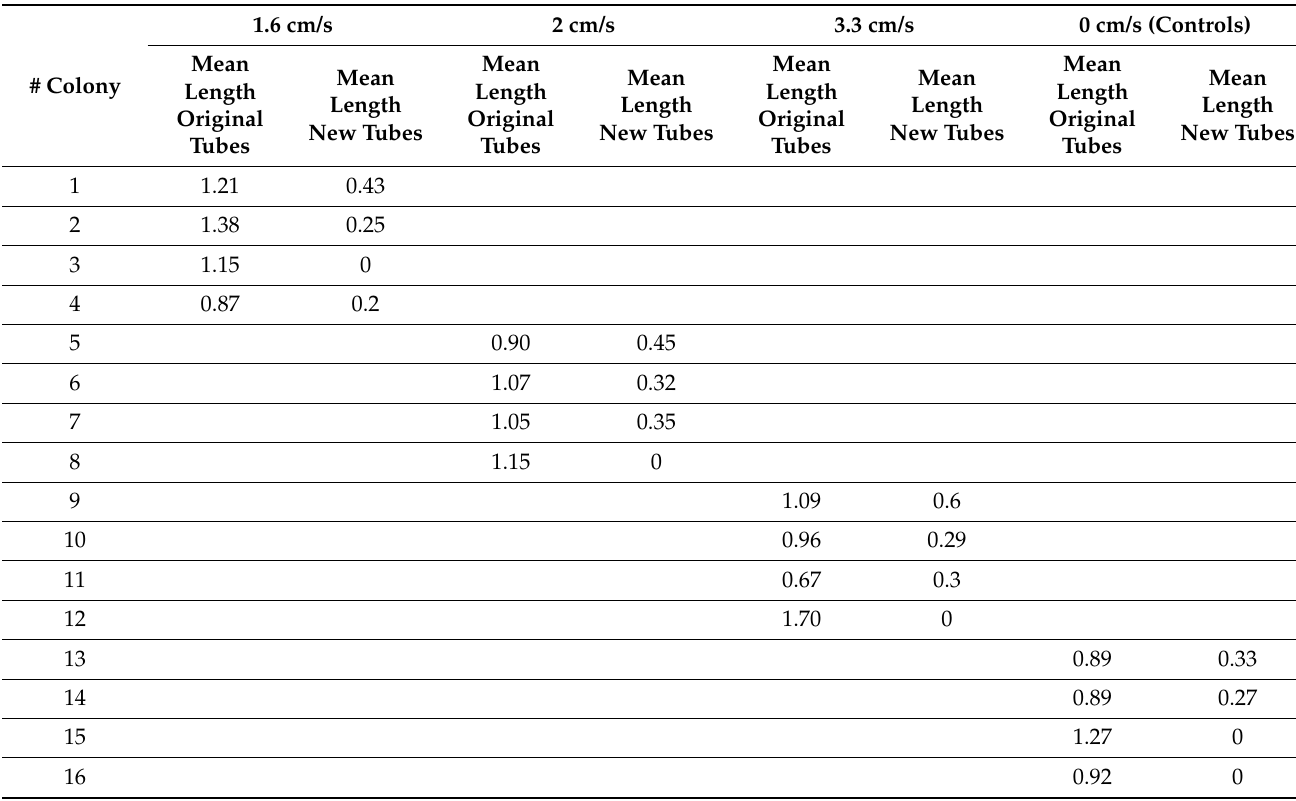
Table 2. Mean tube length for each colony, before and after the flow-induced